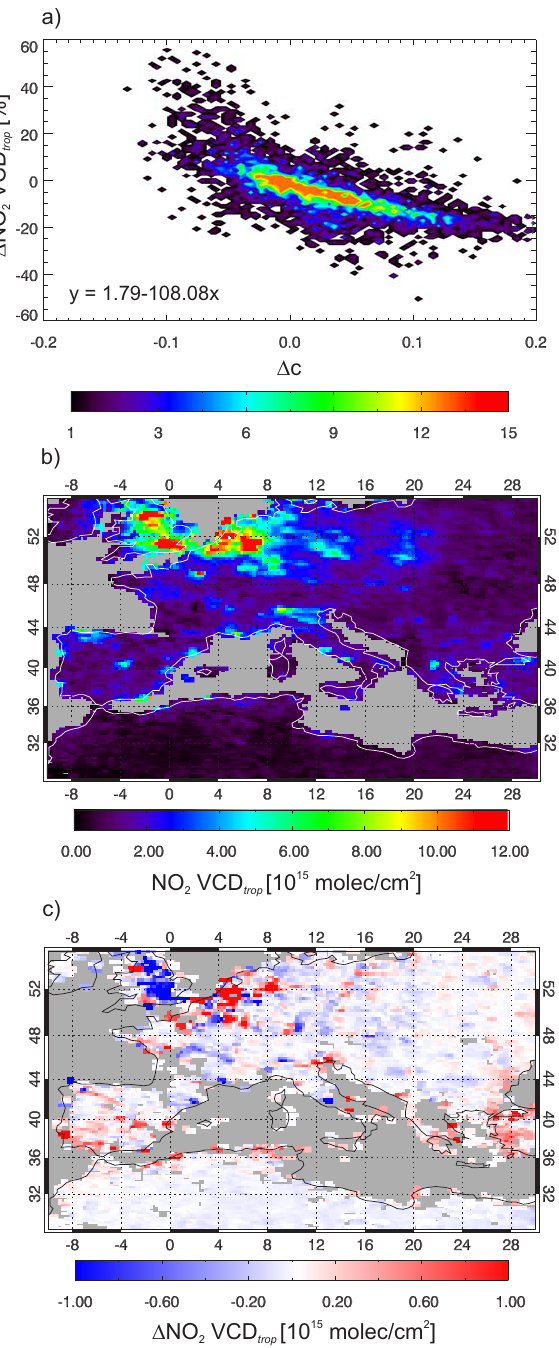
Fig. 11. a) Scatter density plot of the change of SCIAMACHY derived NO 2 tropospheric vertical column density (NO 2 VCD trop ) due to a change of the effective cloud fraction (FRESCO+MERIS - FRESCO+GOME). b) Spatial distribution of NO 2 VCD trop de- rived with the FRESCO+MERIS cloud parameters over Europe for July 2006. c) Difference of the NO 2 VCD trop distribution between the retrievals with FRESCO+MERIS and FRESCO+GOME cloud